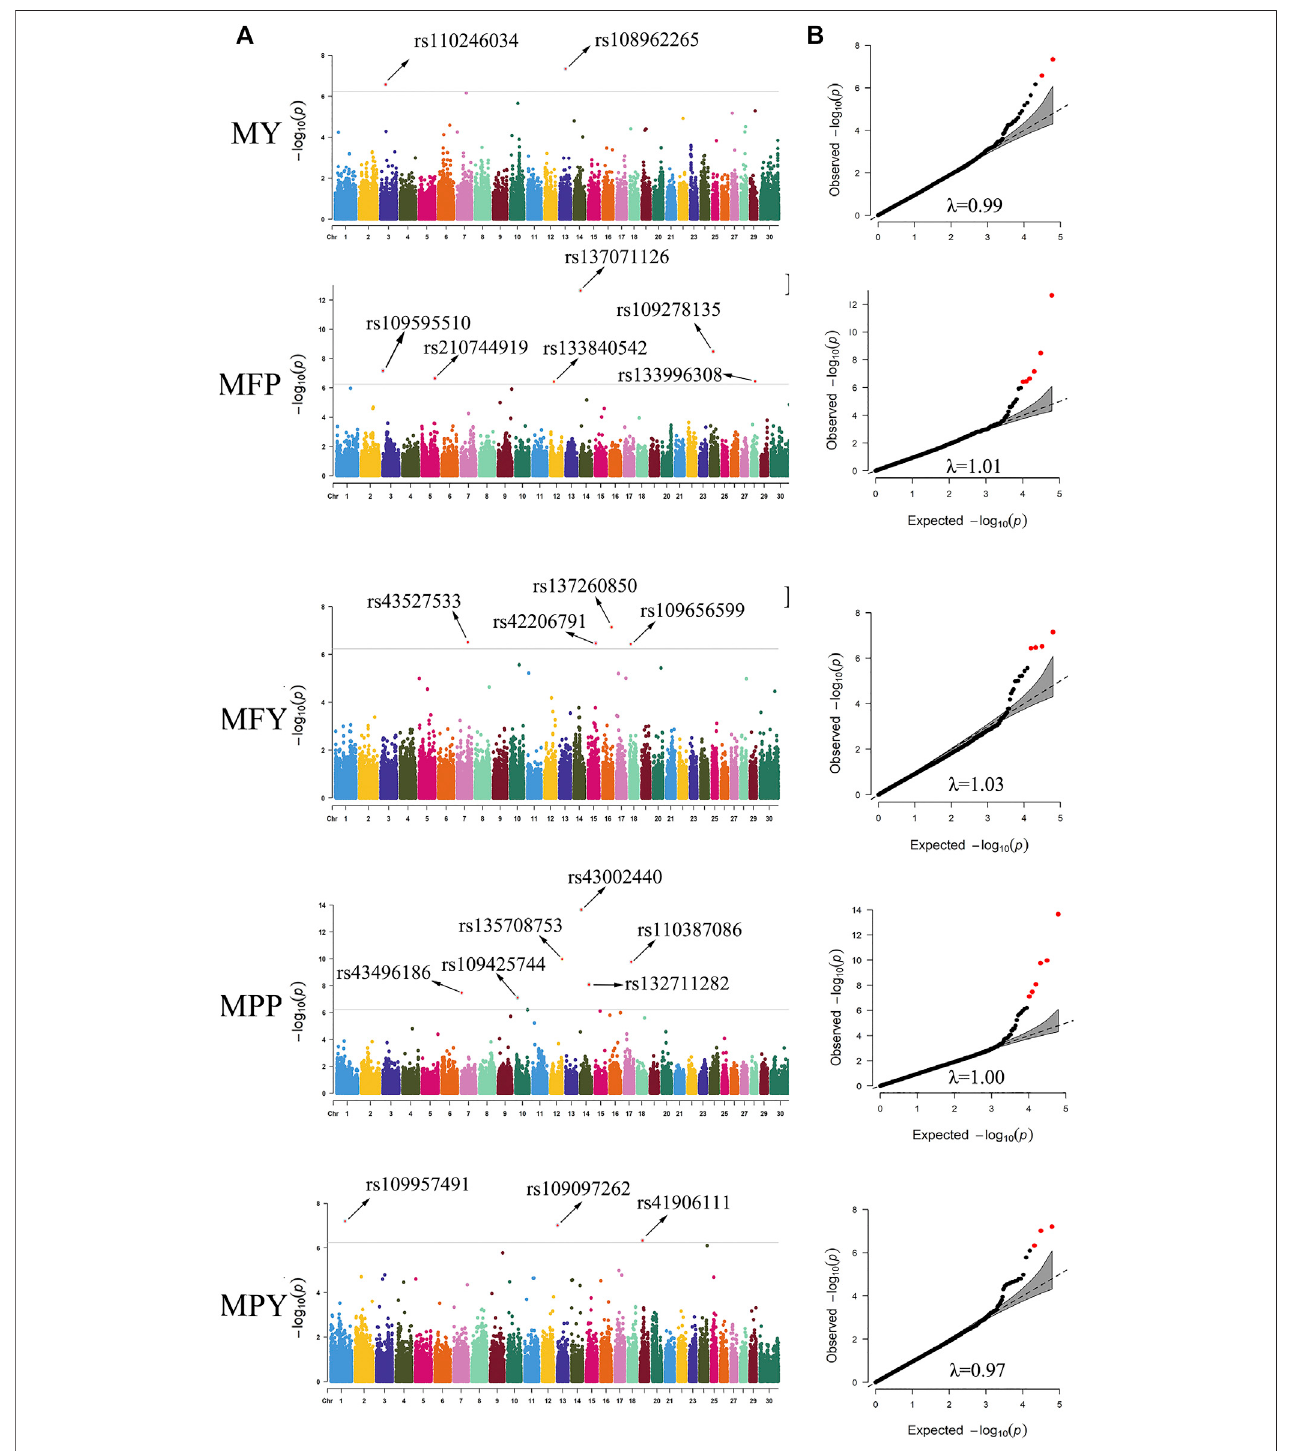
FIGURE 4 | Manhattan plots (A) and quantile-quantile (QQ) plots (B) demonstrated from the genome-wide association study (GWAS) results of the milk-related traits. The signi fi cance threshold was 5.90 × 10 − 7 . The red dots represent the signi fi cant SNPs. The abscissas and ordinates in the Manhattan plots represent the 30 chromosomes of cows and the negative logarithms of the p -values of the variants, respectively (A) . The abscissas and ordinates in the QQ plots represent negative logarithmsoftheexpected p -valuesandnegativelogarithmsoftheobserved p -valuesofeachSNP (B) (MY.milkyield;MFP.milkfatpercentage;MFY.milkfatyield; MPP. milk protein percentage; MPY. milk protein yield, λ . in fl ation factor value).